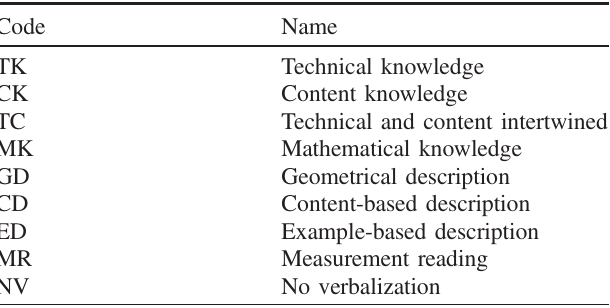
TABLE III. Categories for verbalizations. These are explained in more depth in Table VI in the